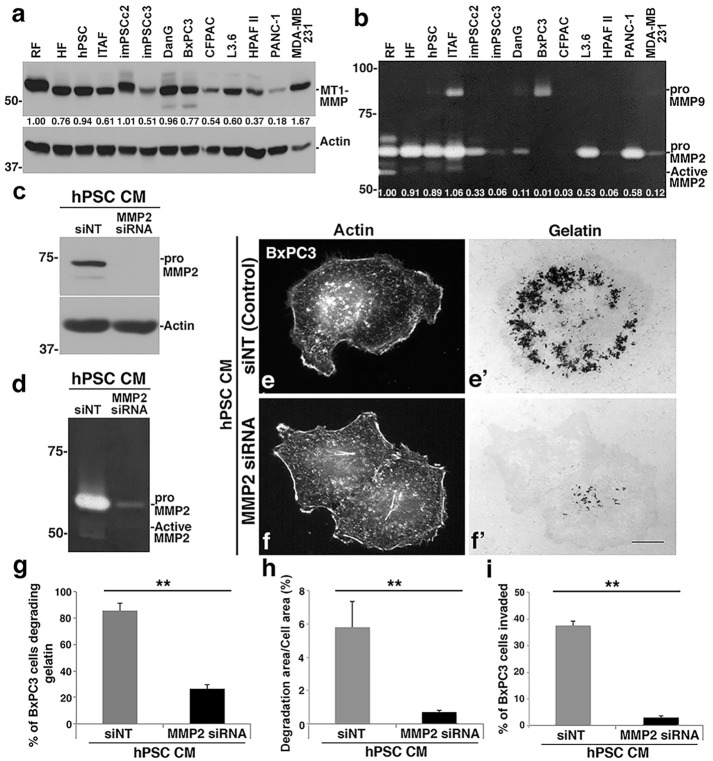
MMP2 in stromal cell conditioned medium is important to drive PDAC cell invasion.(a) Western blot analysis of MT1-MMP protein levels in 6 different PDAC cell lines, 1 breast cancer cell line (MDA-MB-231) and 6 different stromal cell lines. MT1-MMP levels were normalized to actin and compared to RF, and relative values are shown below each band. (b) Corresponding zymographic analysis of MMP2 and MMP9 levels in the same cells. Total MMP2 levels (pro+active) were quantified, normalized to RFs, and are shown below each band. (c-h) MMP2 depletion from fibroblast CM reduces matrix degradation by BxPC3 cells. (c) hPSC cells were treated with control siRNAs or siRNAs against MMP2 for 72 h. The knockdown efficiency of MMP2 in hPSC cells was confirmed by western blot. (d) The depletion of MMP2 in the CM collected from hPSC cells treated with siRNA against MMP2 was verified by zymography. (e) Fluorescence images of BxPC3 cells seeded on green fluorescent gelatin-coated coverslips and then cultured in CM collected from hPSC cells treated with control siRNA or siRNA against MMP2. Depletion of MMP2 in hPSC cells markedly reduced the matrix degradation by BxPC3 cells (f’) compared to the degradation in medium gathered from control cells (e’). The cell area was indicated by phalloidin staining for actin (e, f). Scale bar = 10μm. (g-h) Bar graphs depict quantification of gelatin degradation after 8 h. MMP2 depletion in hPSC CM results in a >3-fold decrease in the percent of BxPC3 cells degrading the matrix (≥100 cells per condition, g) and a >8-fold decrease in the area degraded per cell in BxPC3 cells (≥10 cells per condition, h). (i) The depletion of MMP2 in conditioned medium from hPSC cells inhibited BxPC3 cell transwell invasion. BxPC3 cells were seeded in transwell invasion assays for 6 h with CM from hPSC cells treated with control siRNA or siRNA against MMP2. The results represent the mean ± SEM of 3 independent experiments. *p <0.05. **p <0.01.